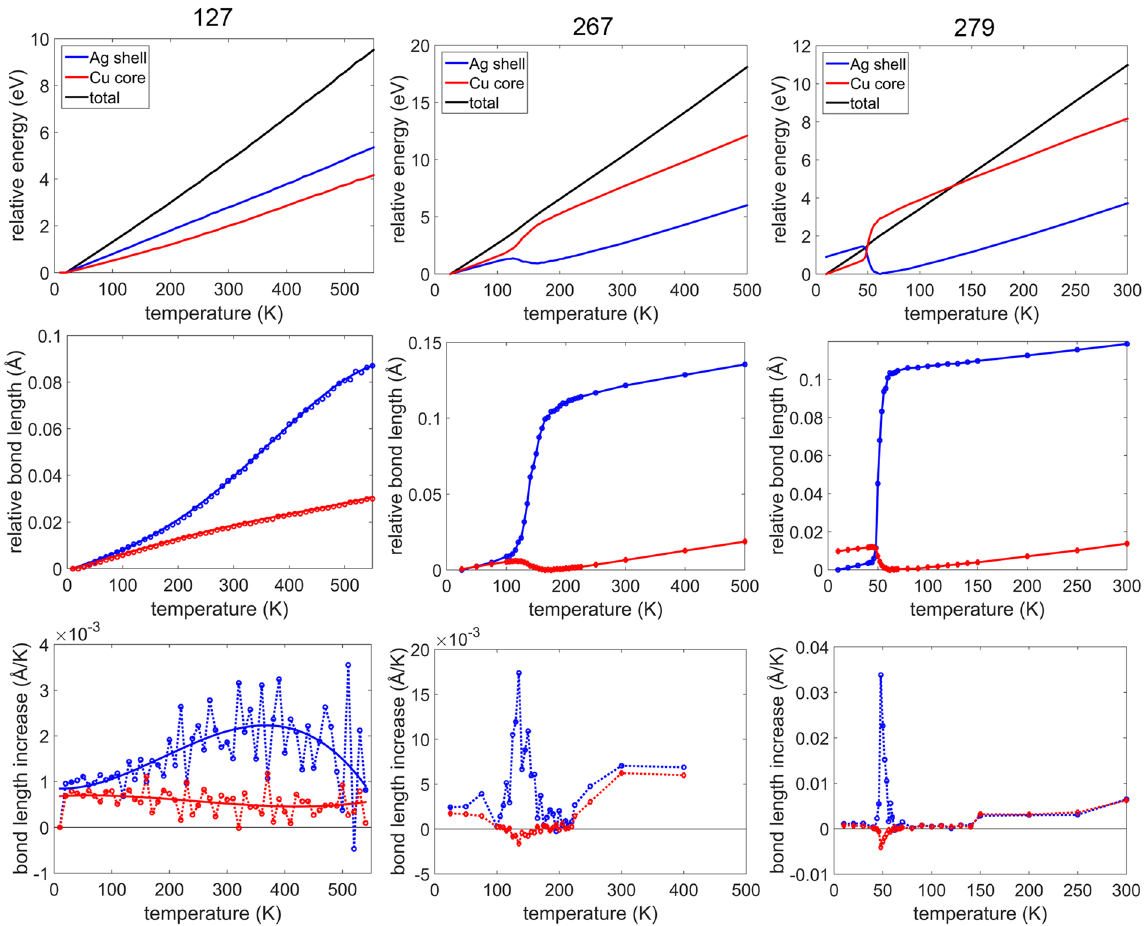
Figure 6. Top row: energy (measured relative to the minimum value) of Ag shell (blue), Cu core (red) and whole structure (black) as function of temperature. middle row: average bond length (relative to the minimum value) of Ag-Ag bonds on shell (blue) and Cu-Cu bonds (red) as a function of temperature. bottom row: rate of change of average bond length plots shown in the middle row. The rate of change of average bond length for 127 (solid line) is based on polynomial fit of the relative bond